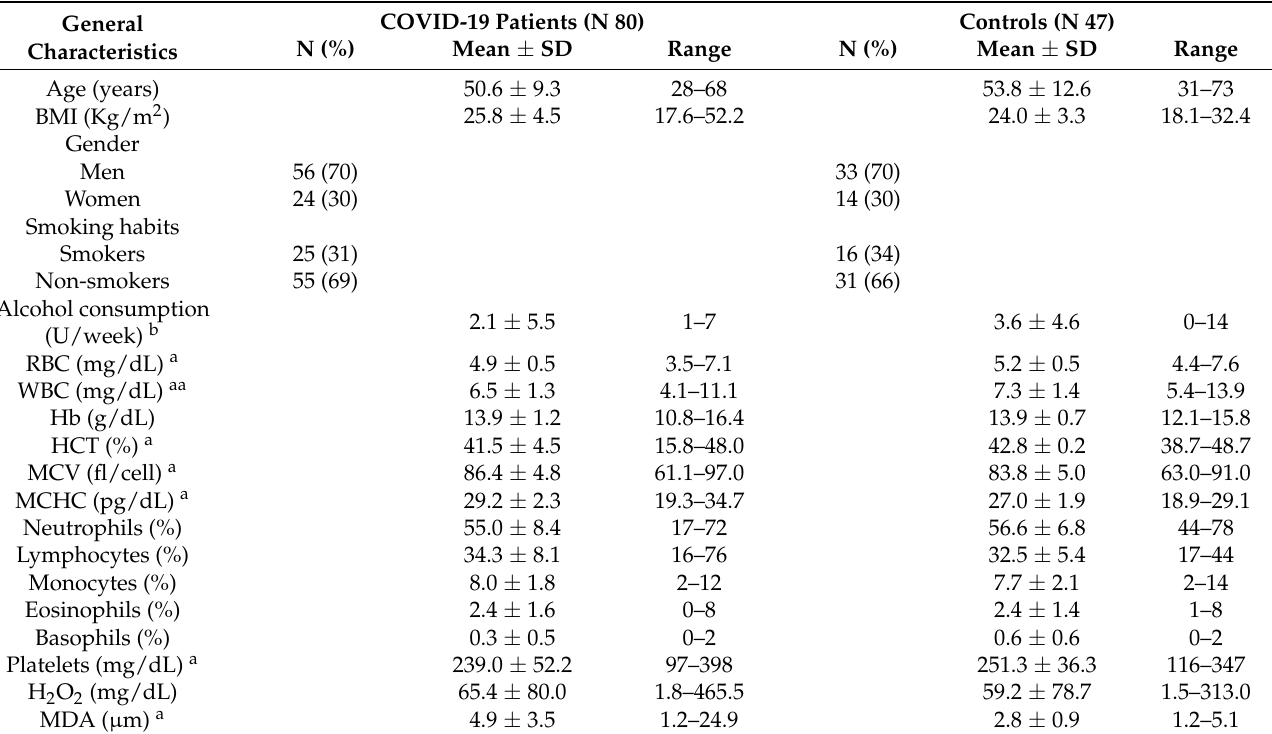
Table 1. General characteristics and clinical parameters of COVID-19 patients and